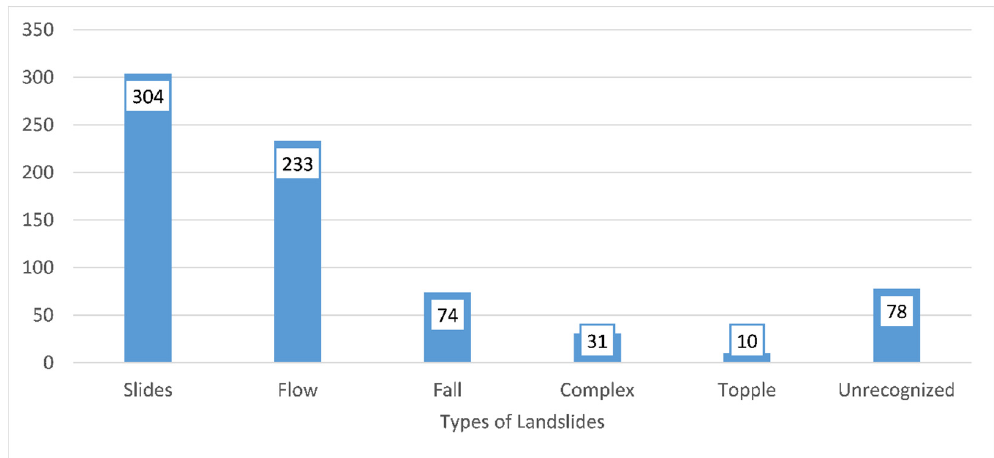
Figure 2. ( a ) Landslides damaged plantation agriculture in Bandarban; ( b ) Landslides damaged bamboo-made house in Rangamati; ( c ) Field work in Rangamati; ( d ) Landslides along the road in Chittagong.